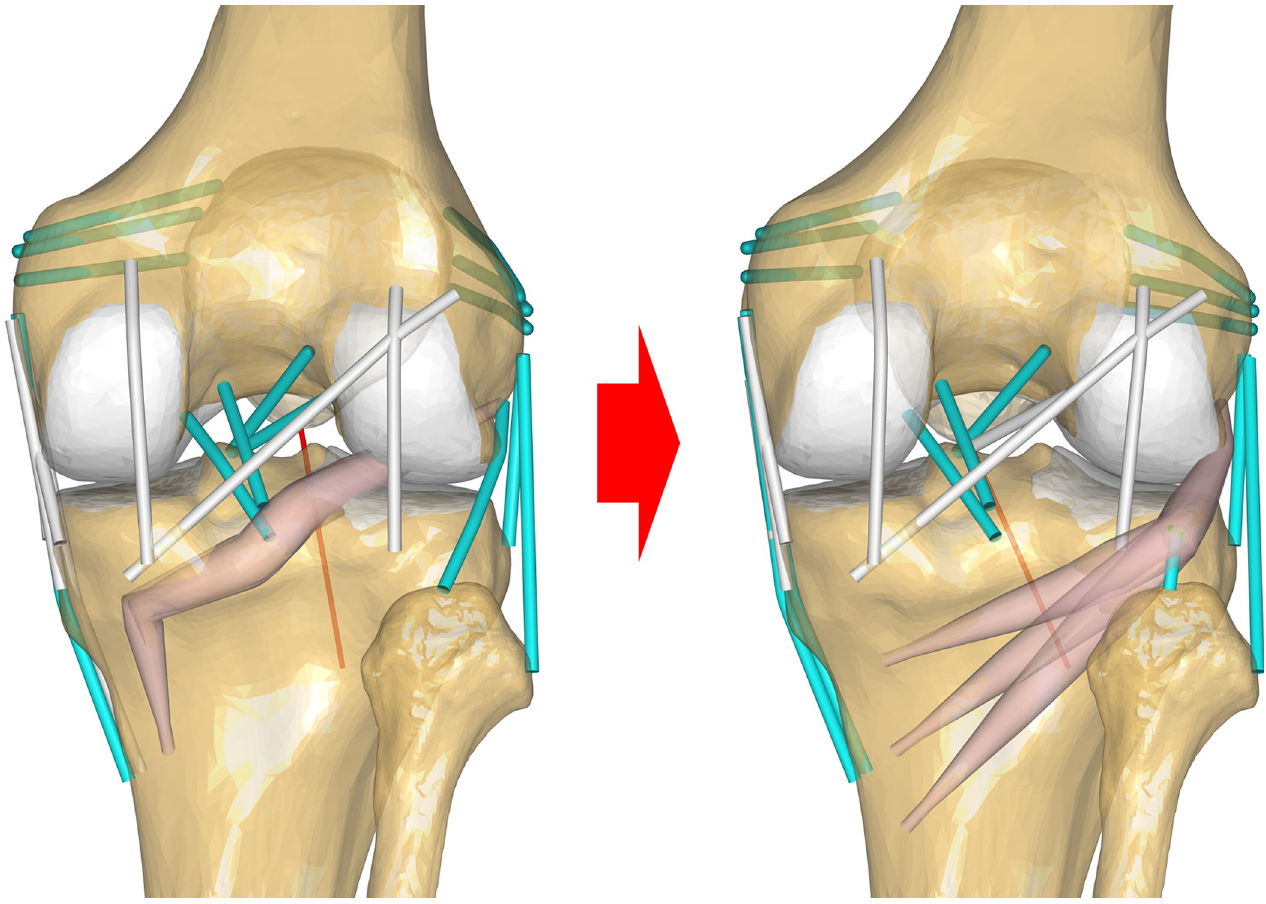
Fig 3. Schematic of the popliteus muscle